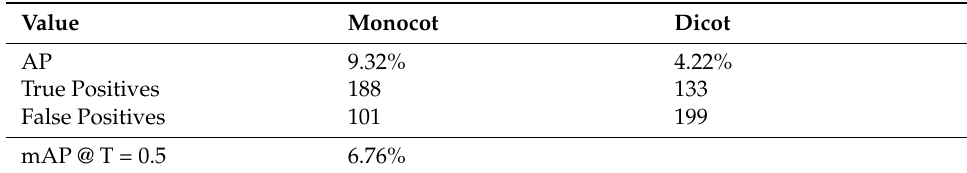
Table 4. Network training results for Training Image Set 2.